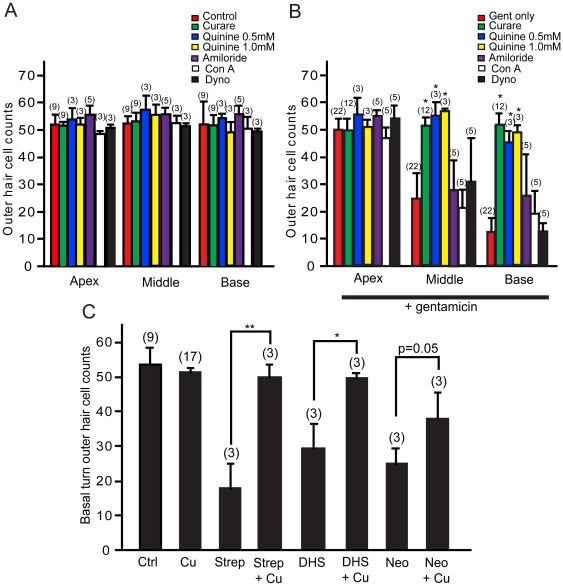
Quantitative analysis of outer hair cell survival.A. Curare, quinine, amiloride, concanavalin A, and dynosore were administered individually to rat cochlear cultures and found not to affect outer hair cell survival (determined by parvalbumin 3 labeling). B. Both curare and quinine provided significant protection to outer hair cells from gentamicin damage in both the basal and middle turns of the cochlea. No significant protection from gentamicin toxicity was observed when cochleae were co-treated with amiloride, concanavalin A or dynosore. C. Curare significantly improved outer hair cell survival in the basal turn of cochleae exposed to various aminoglycosides, including streptomycin and dihydrostreptomycin, but not neomycin. Error bars = S.D. * = p<0.001, ** = p<0.01.